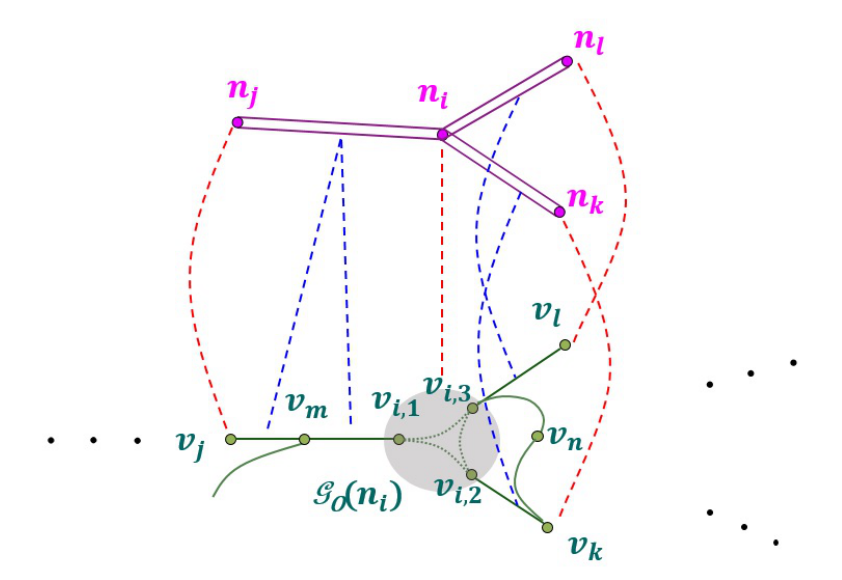
Figure 8. Example of RNM results.